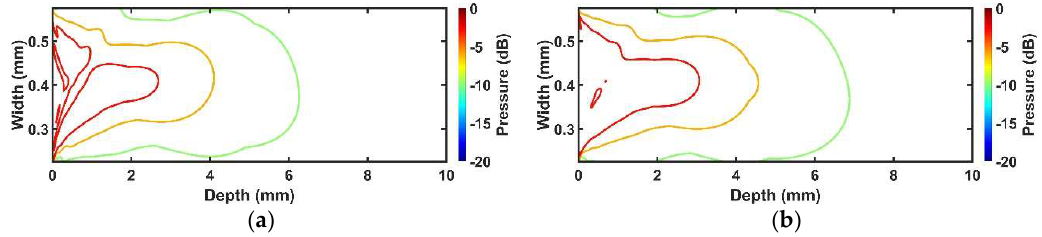
Figure 6. Simulated pressure fields of two transducers: ( a ) Conventional transducer; and ( b ) proposed transducer. Each contour plot indicates − 3 dB, − 6 dB, and − 10 dB pressure distribution. Table 7. Penetration depth calculation based on pressure field simulation results of the conventional and proposed transducers.